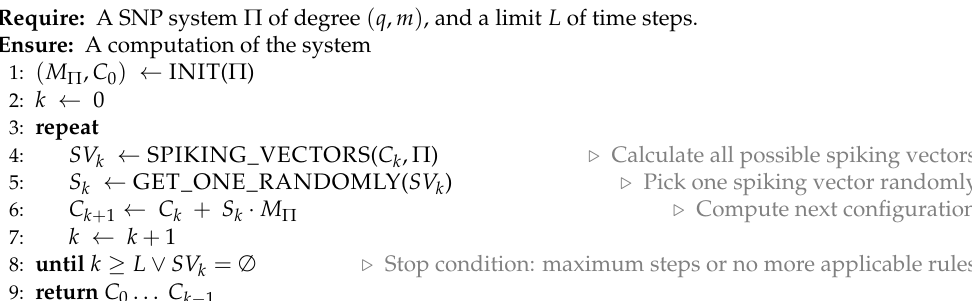
Algorithm 1 MAIN PROCEDURE: simulating one computation for static spiking neural P